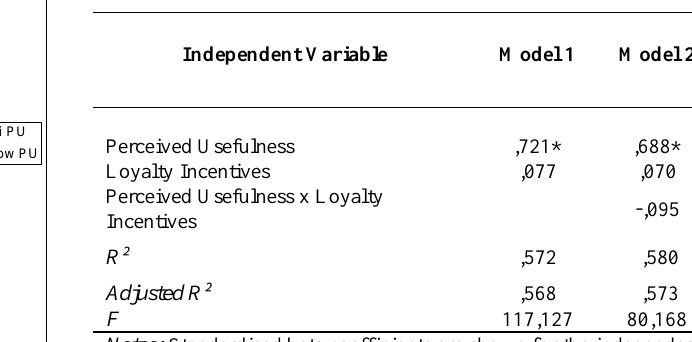
Table 7: Loyalty incentives as a